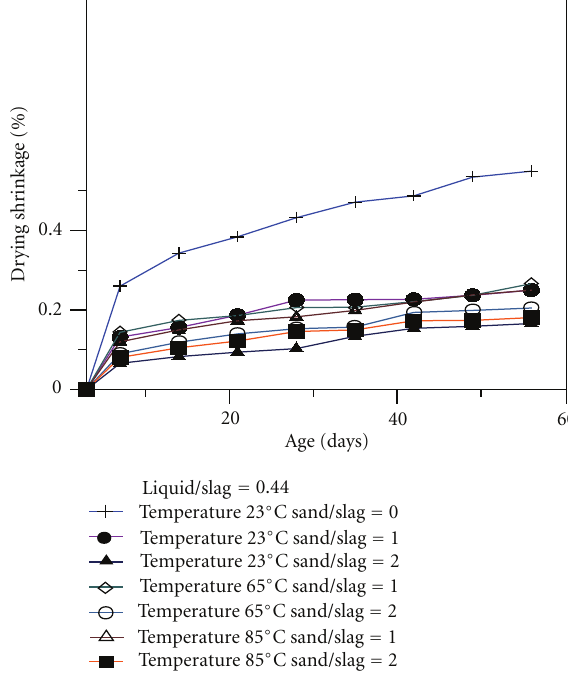
Figure 7: Tensile strength of AAS mortars ( L/S = 0 . 64).